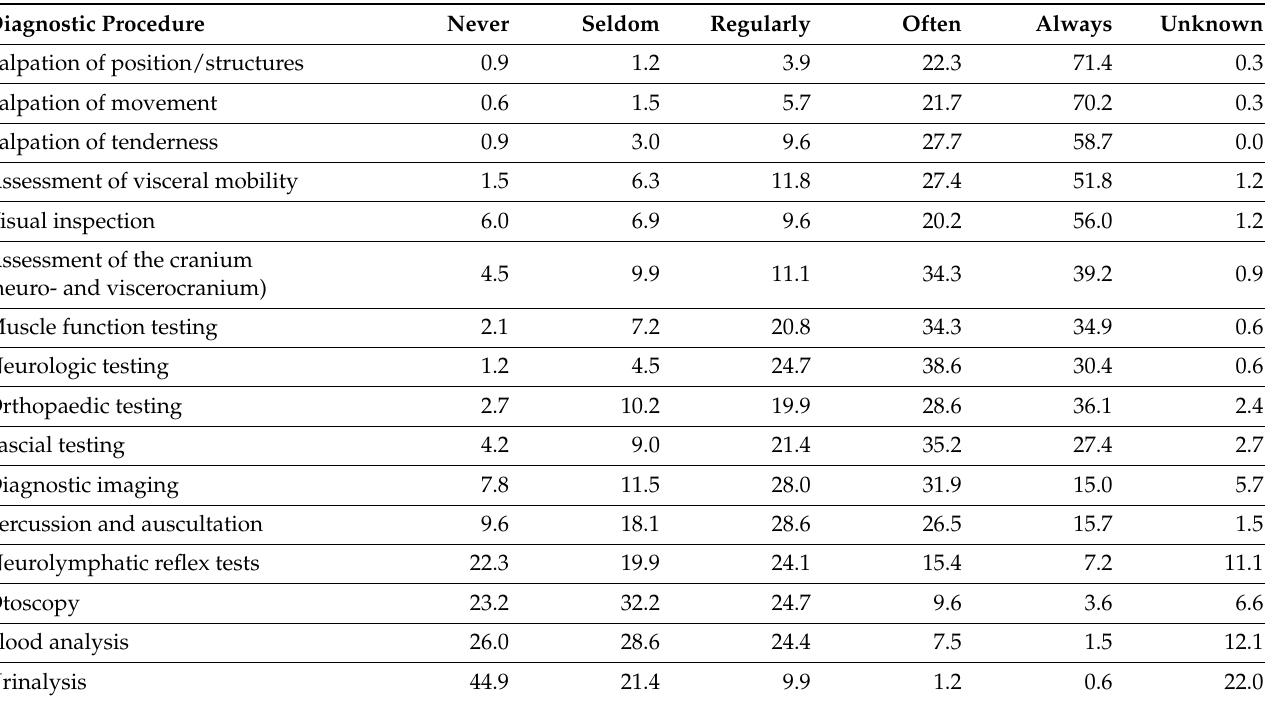
Table 5. The most common diagnostic procedures (in descending order of ‘often’ and ‘always’ responses).